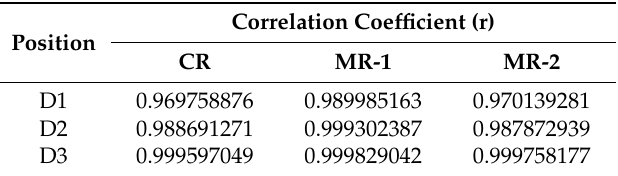
Table 4. Correlation analysis results of GPC curves.